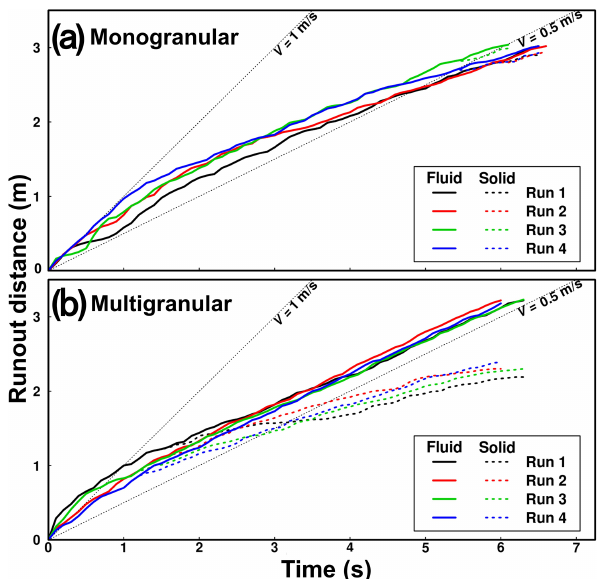
Figure 4. Change in runout distances of the flow fronts with time: (a) monogranular flows and (b) multigranular flows. Continuous and broken lines indicate runout distances for the fluid and solid phases, respectively. Dotted black lines are assumed graphs for ve- locities of 0.5 and 1ms − 1